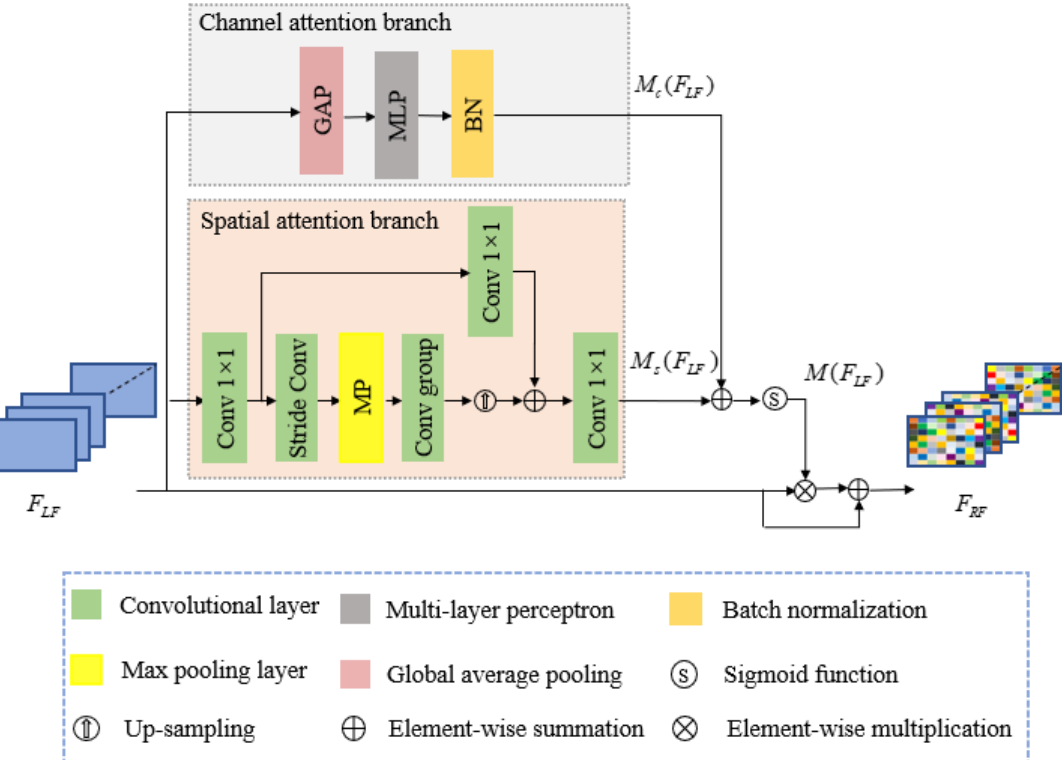
Figure 4. Proposed joint attention module (JAM) structure.